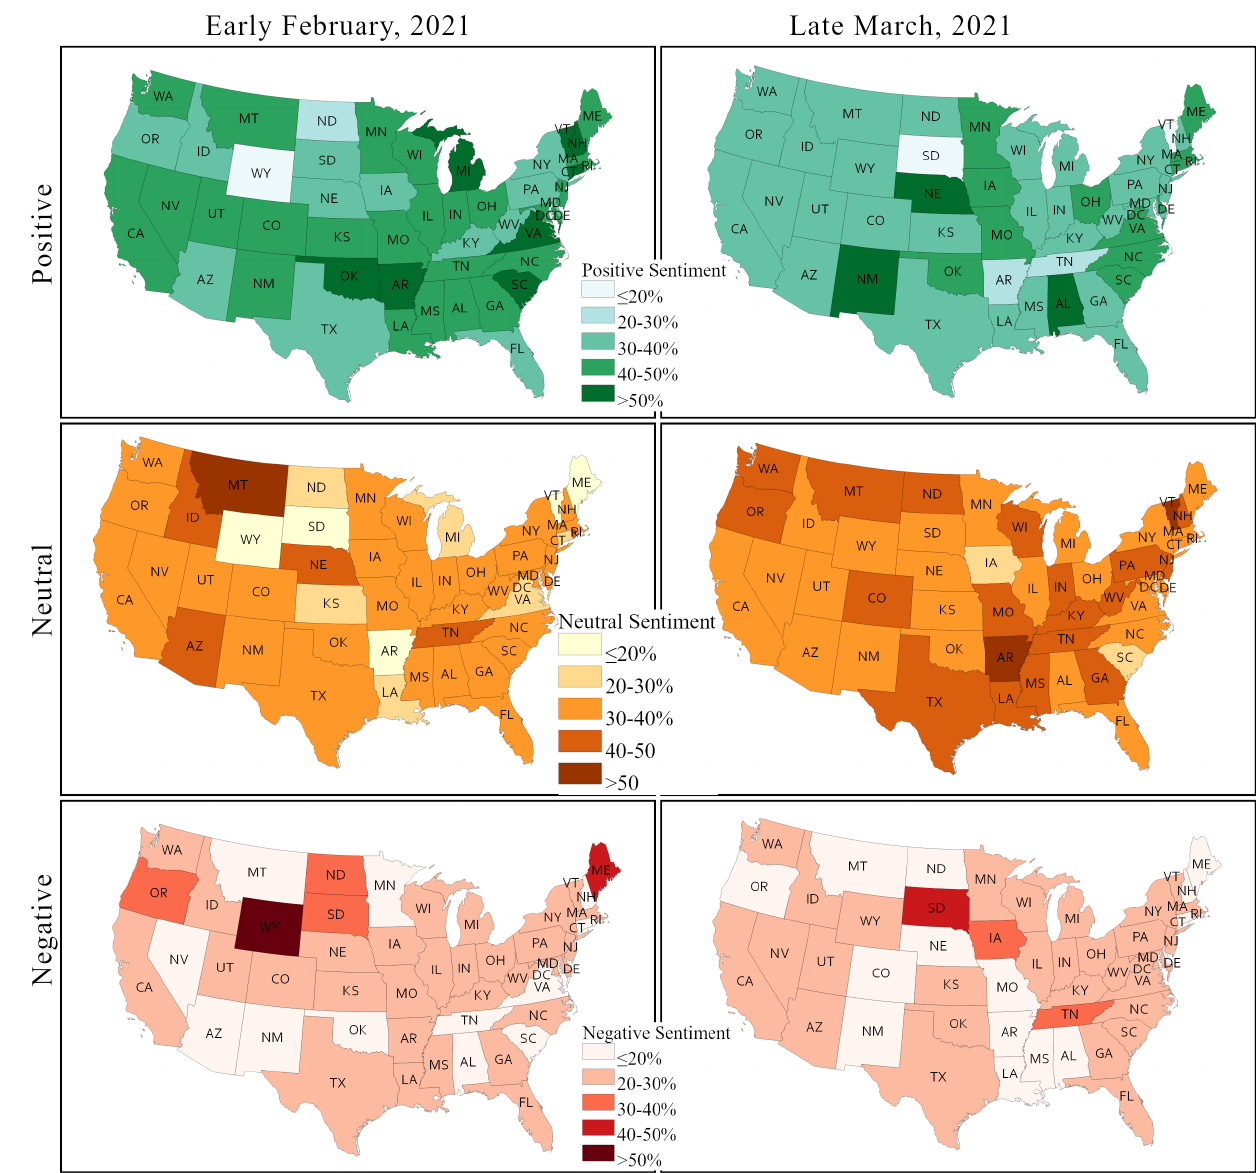
Figure 11. Changes in positive, neutral, and negative sentiment in US